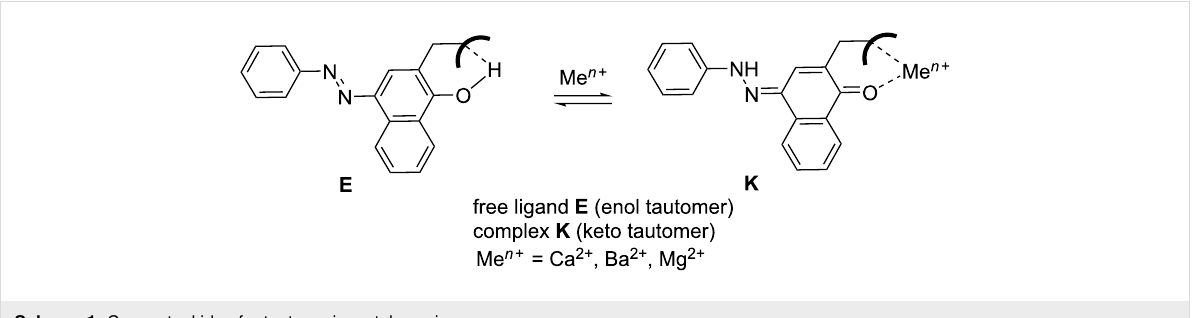
Scheme 1: Conceptual idea for tautomeric metal